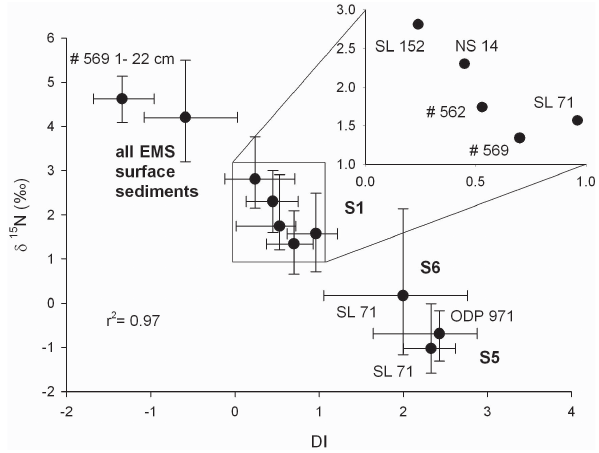
Fig. 5. Mean values of δ 15 N vs. DI for S1, S5 and S6 sapropels, core #569 and all Eastern Mediterranean surface